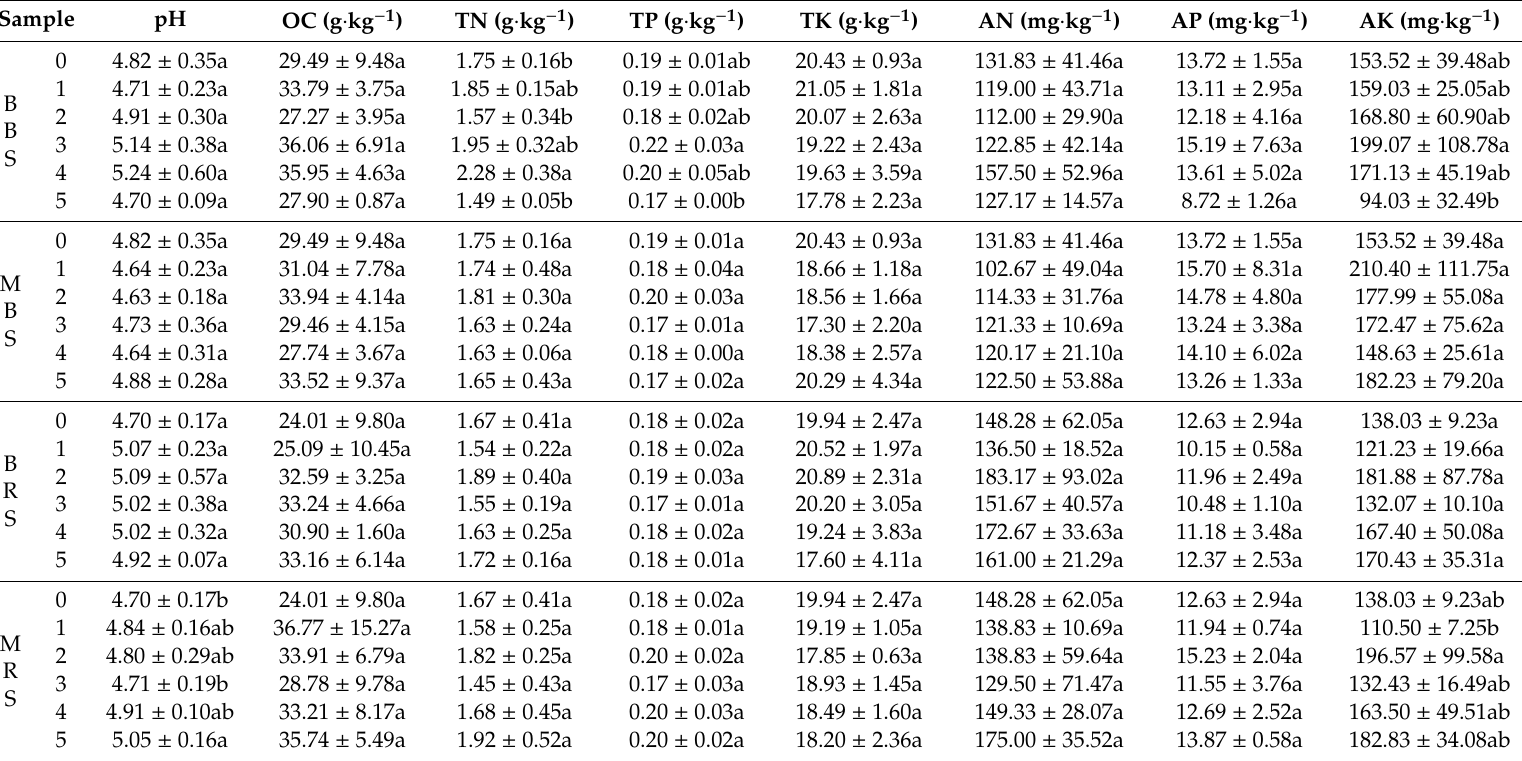
Table 2. Soil chemical properties at di ff erent biochar addition dosage in bulk soil and rhizosphere